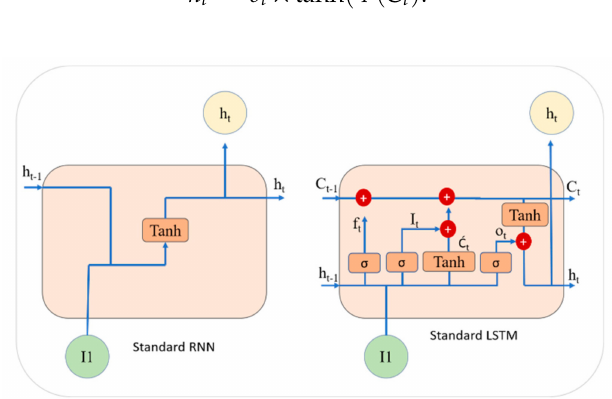
Figure 5. Standard architecture of RNN and LSTM.